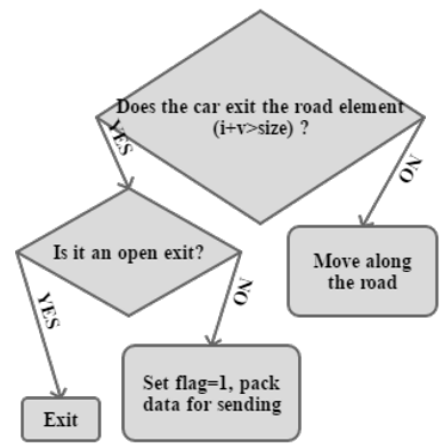
Fig. 3. Block-scheme of the algorithm of driving around a wide obstacle.